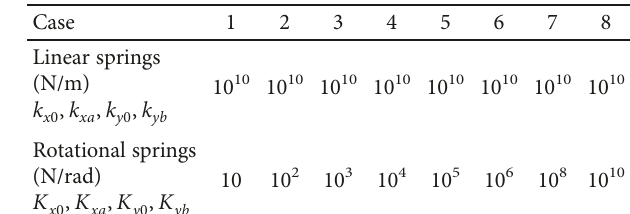
Table 4: Boundary conditions.